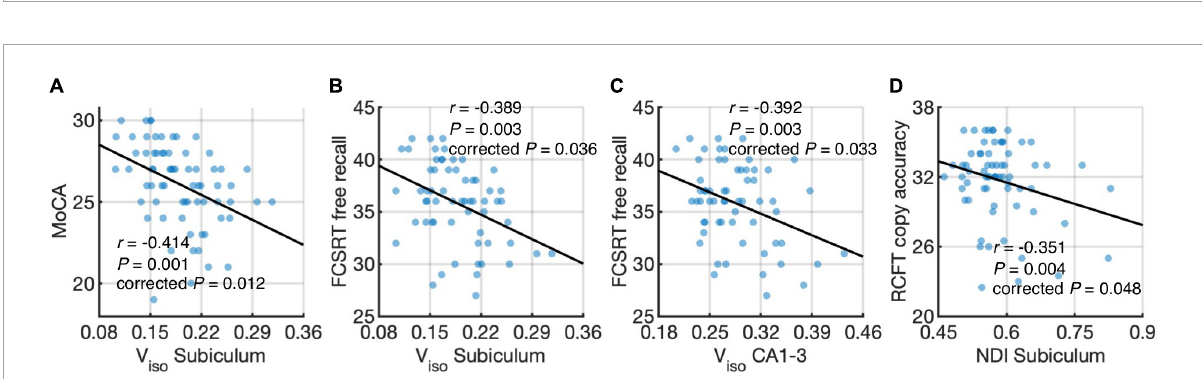
FIGURE5 Correlations of hippocampal subfield connectivity and diffusion metrics with neuropsychological performance: volume fraction of isotropic water diffusion (V iso ) in the subiculum vs. the Montreal Cognitive Assessment (MoCA) score (A) V iso in the subiculum vs. Free and Cued Selective Reminding Test (FCSRT) free recall score (B) V iso in CA1-3 vs. FCSRT free recall score (C) and neurite density index (NDI) in the subiculum vs. Rey Complex Figure Test (RCFT) copy accuracy score (D) . The associations were evaluated using partial correlation with age, sex, normalized whole hippocampal volume, and total intracranial volume as covariates. P -values were adjusted for multiple comparisons using Holm-Bonferroni correction. The fitting lines are also shown to indicate